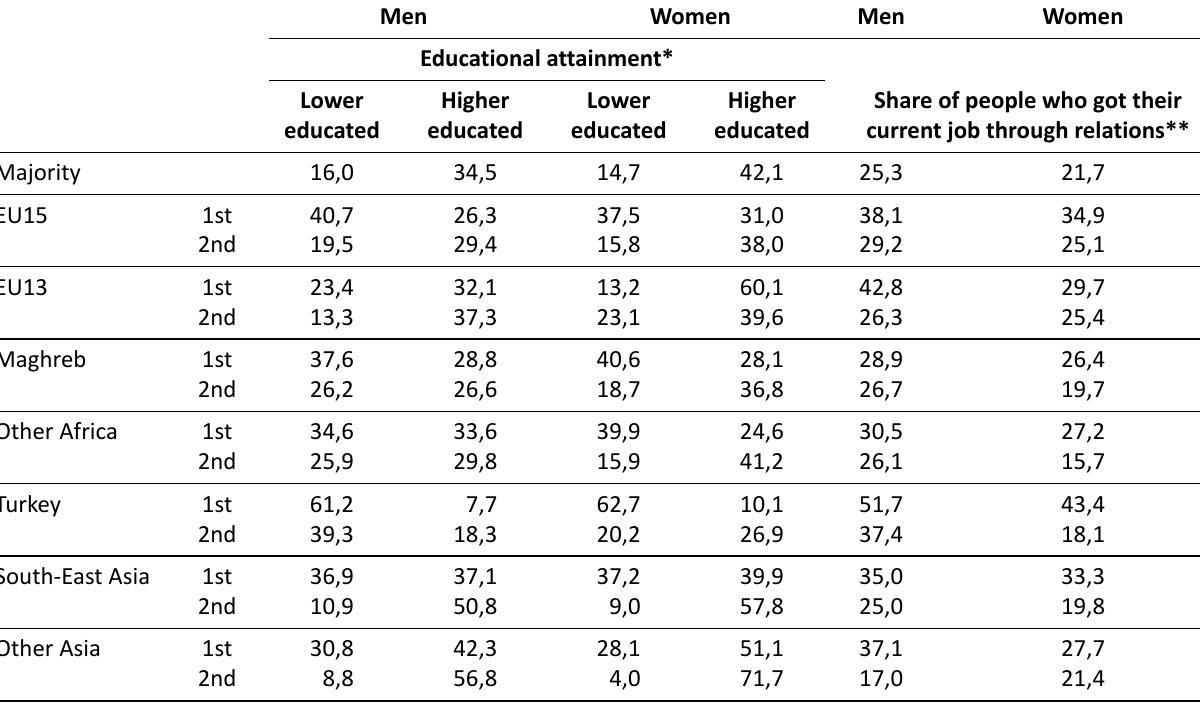
Table A2. Educational attainment of active and share of employees who got their current job through relations, by origin groups, generation and by gender (%). Source: INSEE Labour Force Survey